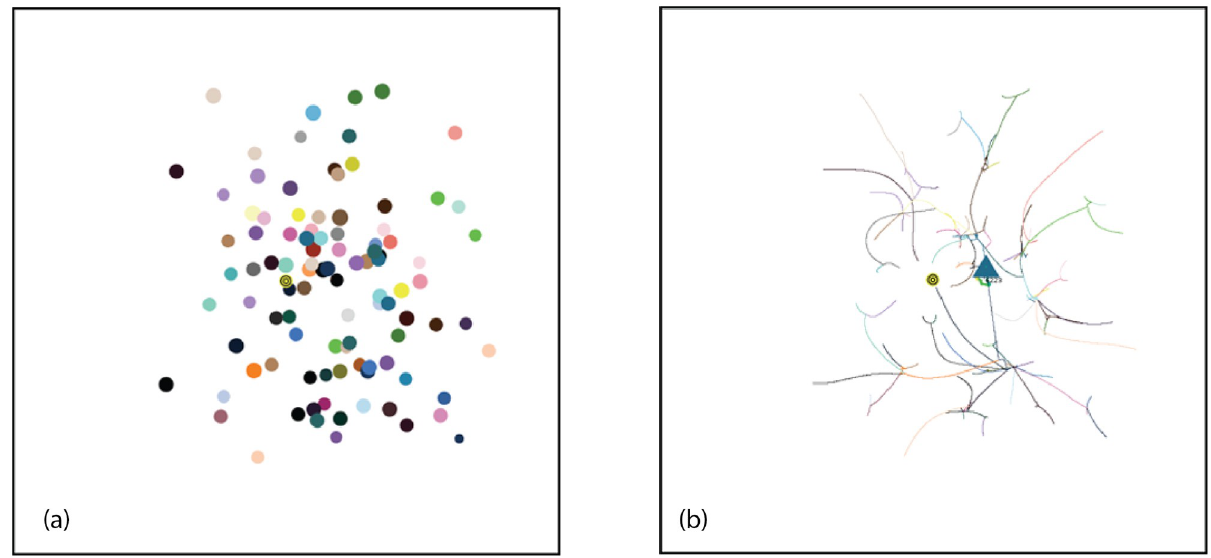
Fig 20. Example of random distribution centered at (20,0) leading to consensus. Seed = 91, AIB = 60, final location of group = (19.6, 4.9): a) Start and b) End of simulation.